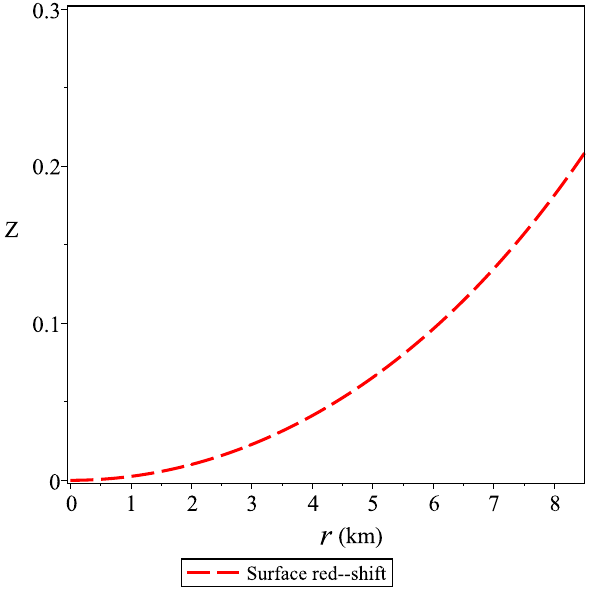
Fig. 10 Plot of the surface red-shift versus the radius r using the con- stants constrained by PSR J